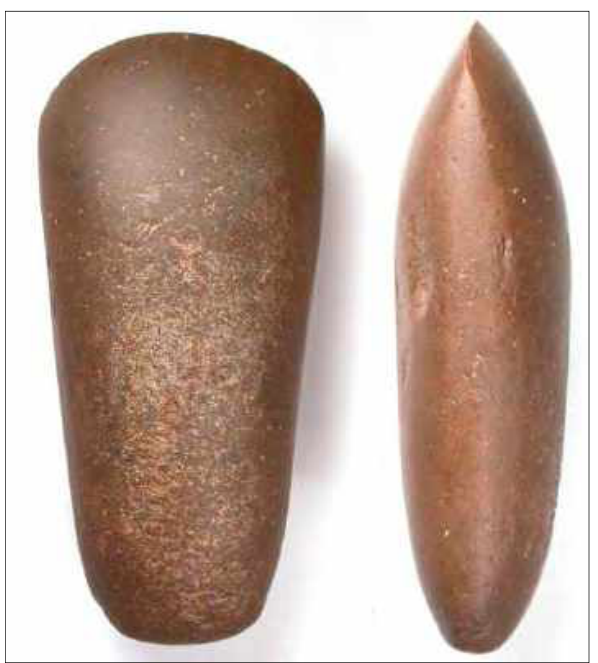
Fig 2.24 Neolithic polished stone axe from Moston, Crewe and Nantwich, Cheshire (Cheshire County Council).